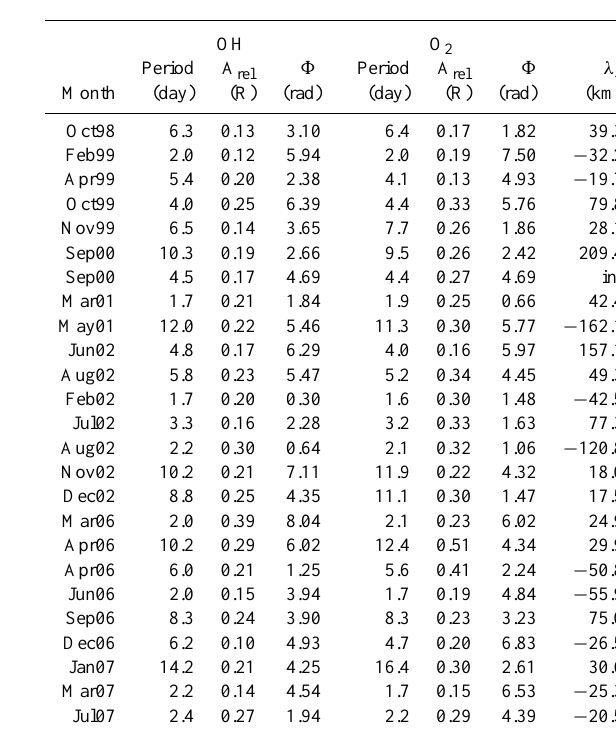
Table 3. Wave parameters detected in emission rate